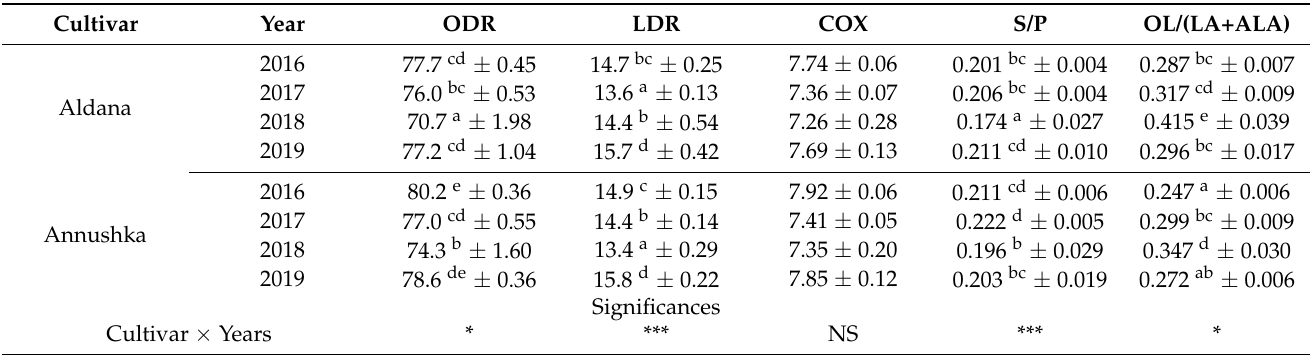
Table 8. The ODR, LDR and COX indices and the S/P, OL/(LA+ALA) ratio of lipid quality in G. max seeds; mean values for interaction cultivar × years.